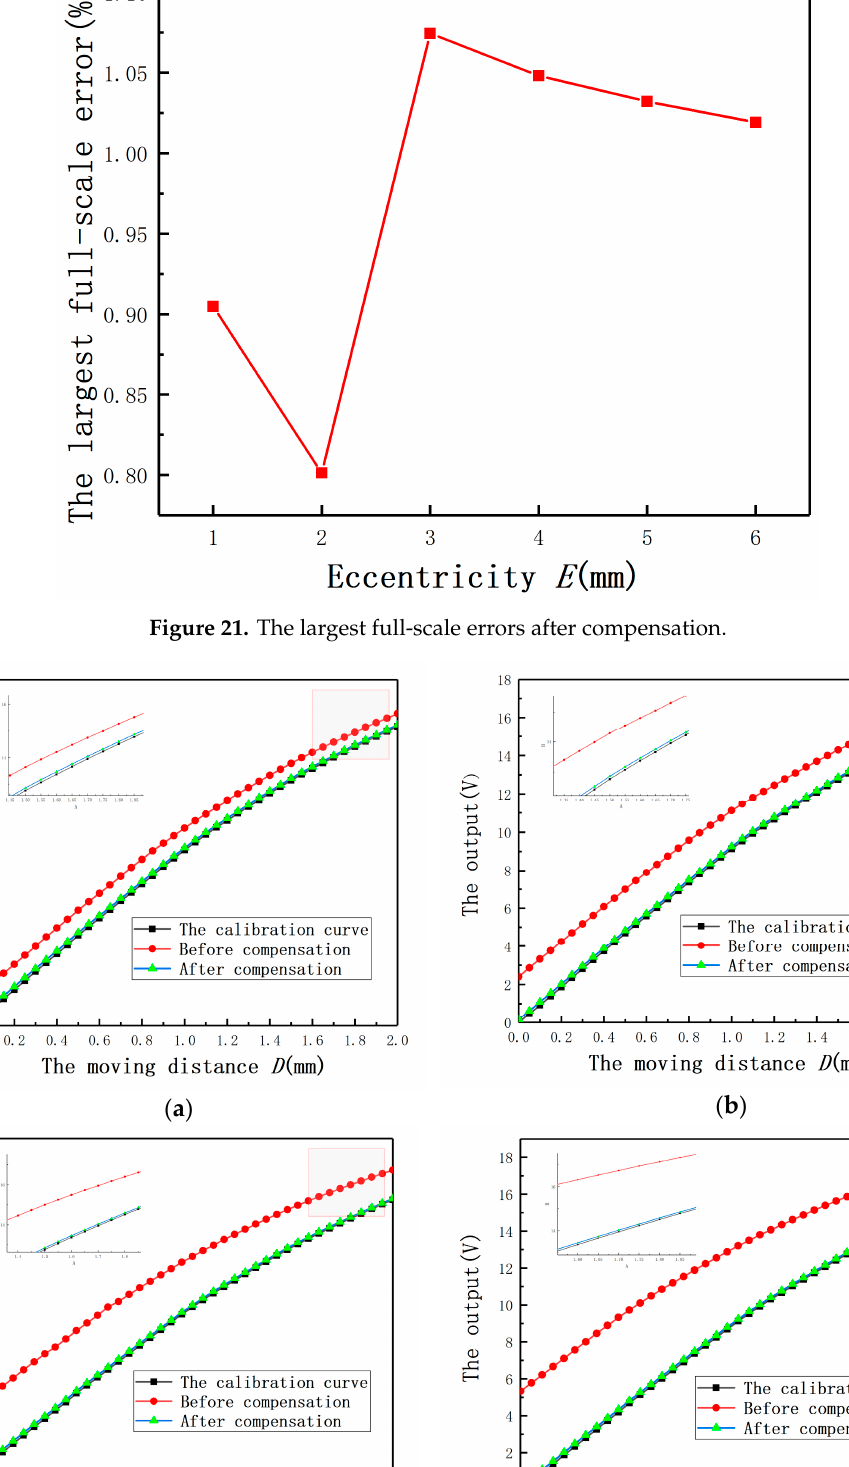
Figure 20. The largest measurement errors and the average measurement errors after compensation.